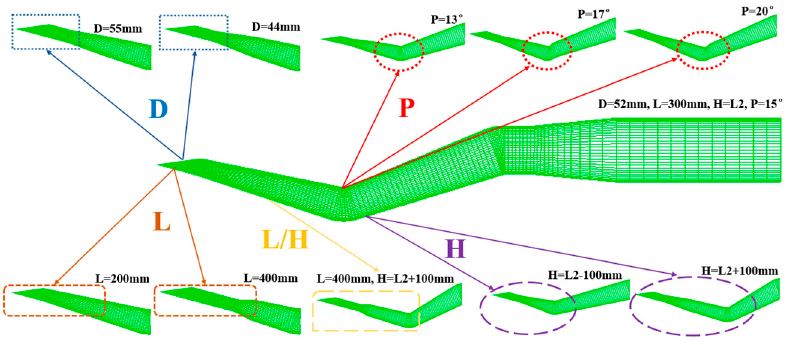
Figure 2. Geometric outline and parameters of the V-shaped support: ( a ) different sections of the V- shaped support; ( b ) outline of a BWB model with the V-shaped support; ( c ) geometric parameters of the V-shaped support.